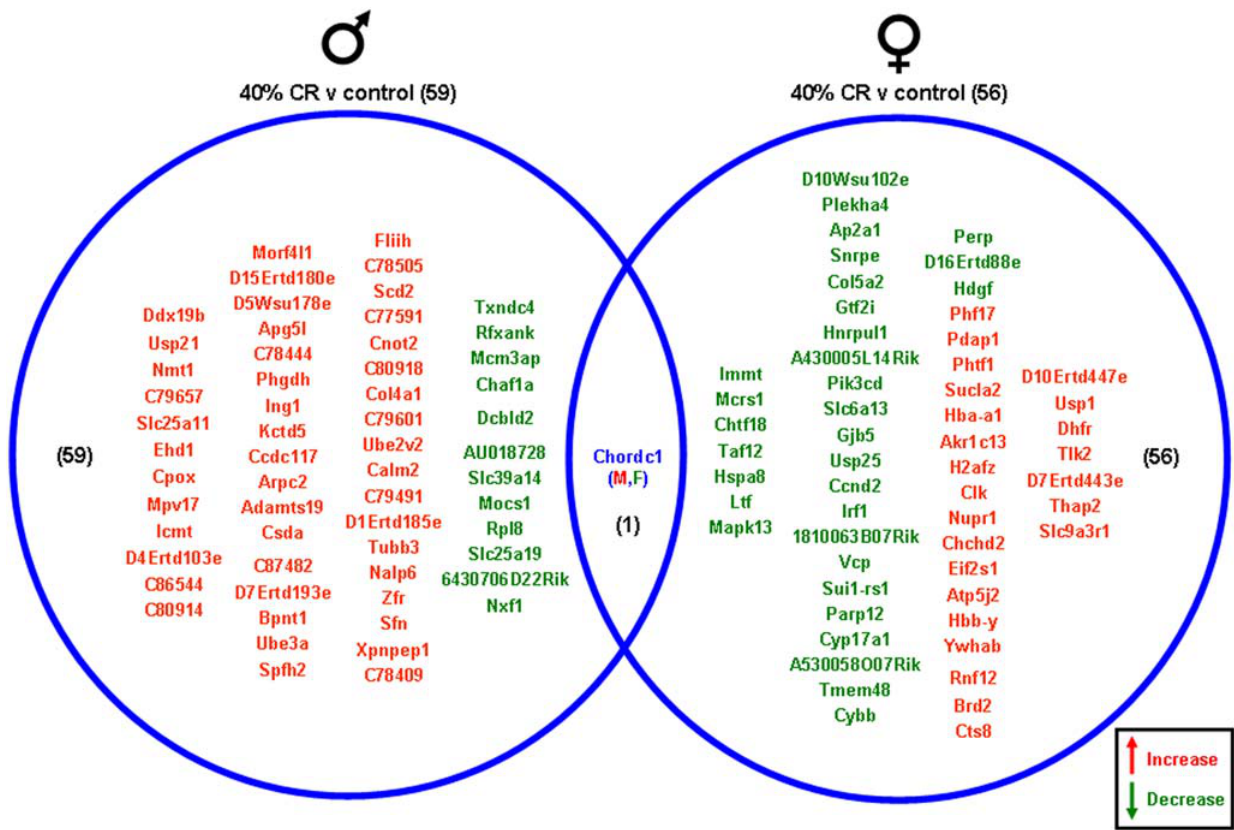
Figure 4. Gene changes in the gonads of male and female rats maintained on a 40% CR diet compared to the gonads of rats maintained on a control ( adlibitum ) diet. Genes that were significantly up-regulated (red) or down-regulated (green) were clustered into a Venn diagram. There were 47 significantly up-regulated and 12 significantly down-regulated genes in the testes collected from 40% CR male rats compared to controls. Ovaries collected from 40% CR female rats showed 24 significantly up-regulated (red) and 32 significantly down-regulated (green) genes compared to the control ad libitum females. There was 1 common gene altered in the gonads of both the male and female rats in this dietary group. This gene, chordc1, was up regulated in female gonadal tissue and down regulated in male gonadal tissue. Names of the significantly altered genes can be found in Table S1. testes, 50% of the multi-dietary paradigm-regulated genes in the ovaries were CR-specific (Figure 7B). Amongst the significantly regulated genes there appeared to be clusters related to growth factor action (Hdgf, Gdf9), mitochondrial function (Immt, Prss25) and translation (Eif2s1, Taf12).